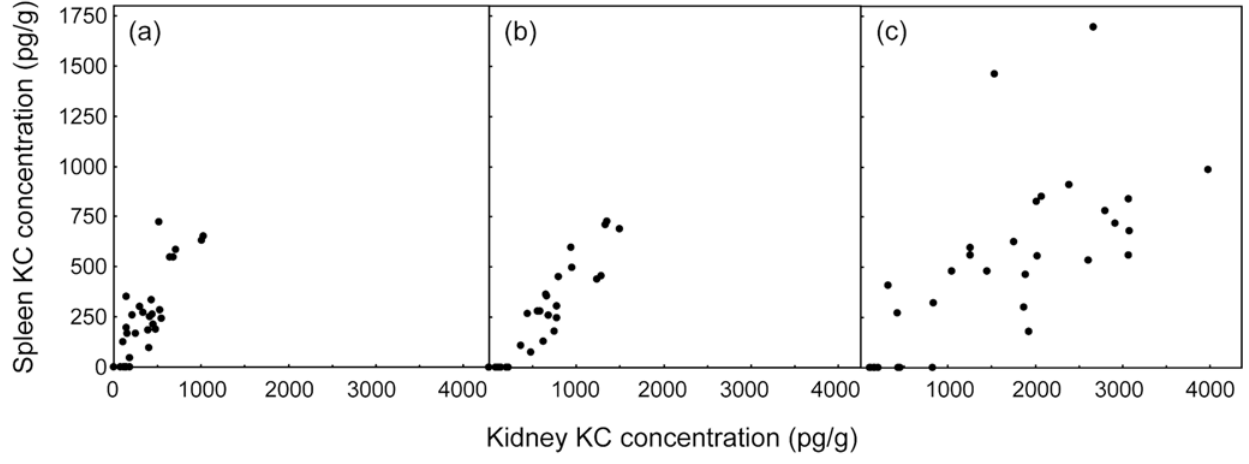
Figure 8. Scatterplots of KC concentrations in kidney vs. spleen measured at (a) 12 h, (b) 24 h and (c) 48 h after intravenous challenge of mice with 11 C.albicans